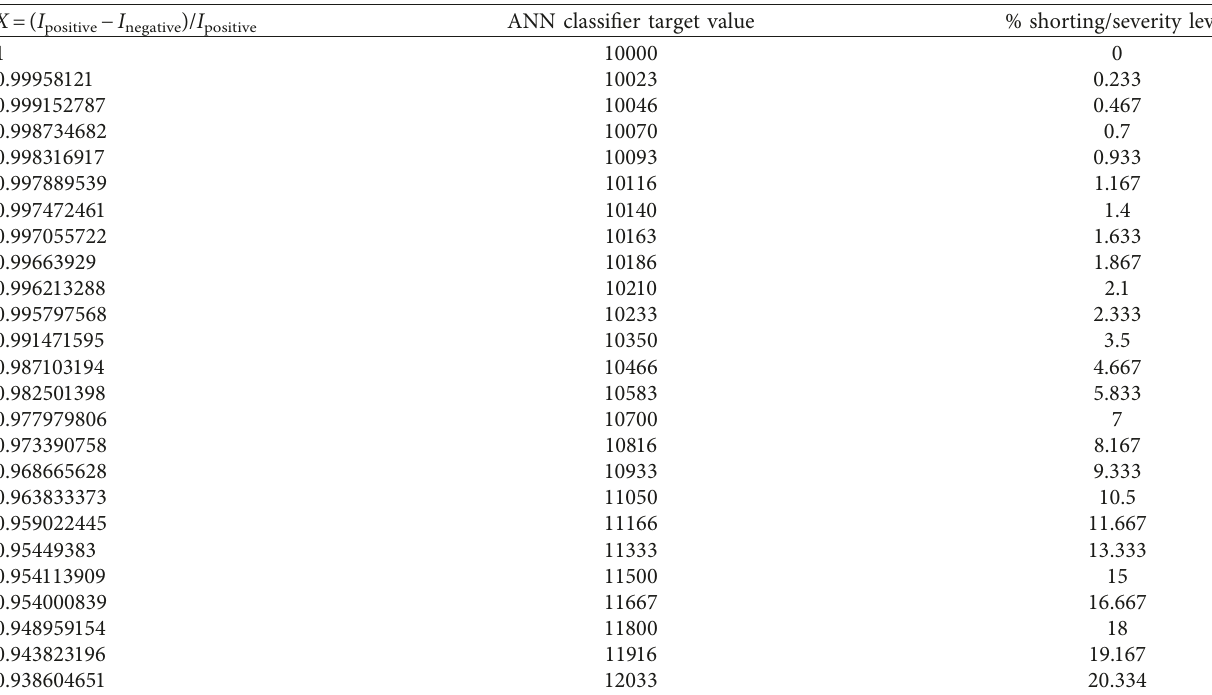
Figure 4: Block diagram of processes. Table 5: Input and target values for